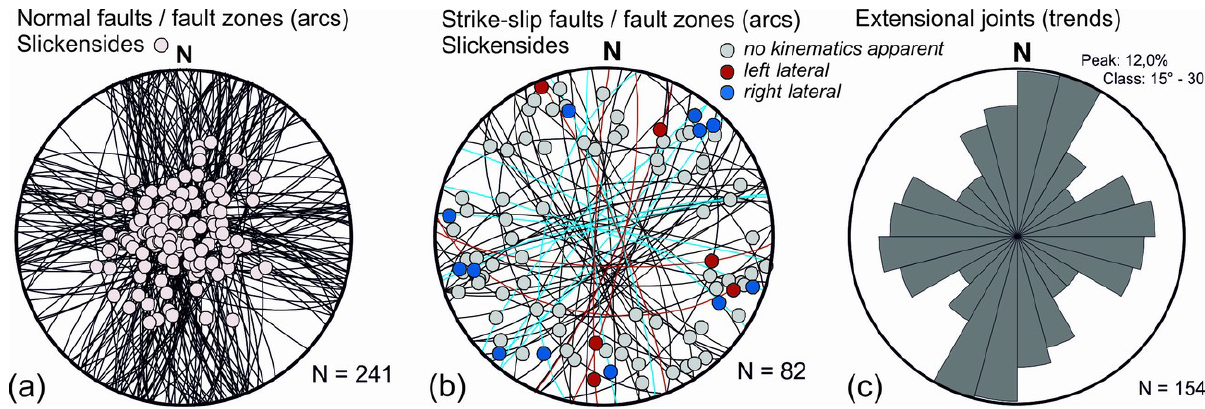
Figure 5. Field structural measurements of faults (equal area projection to the lower hemisphere) and extensional joints (rose diagram) from the southern part of the Main Ethiopian Rift (Hossana and Dilla areas).